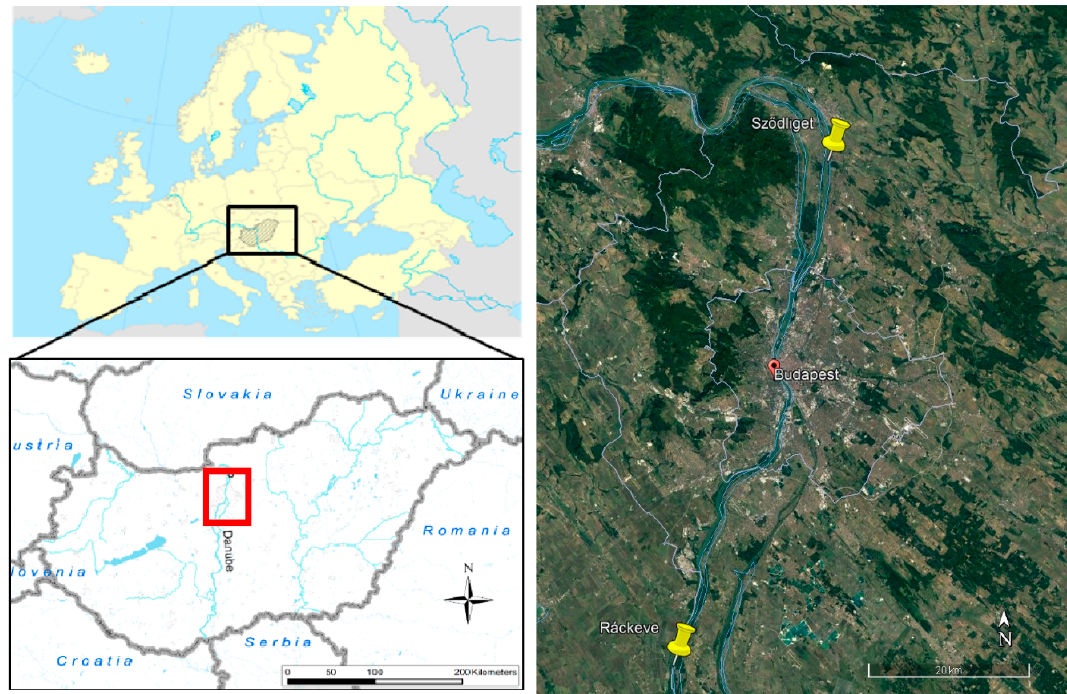
Figure 1. Case study areas in the Hungarian section of the Danube River at the settlements near Sz ő dliget (north of Budapest) and Ráckeve (south).